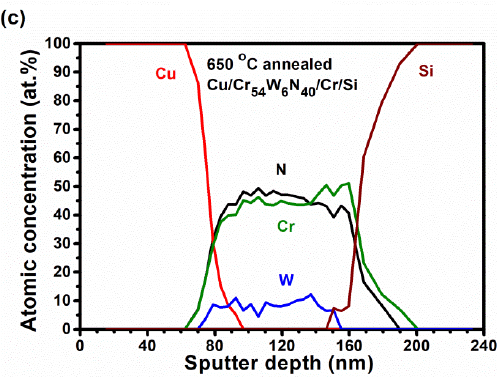
Figure 15. AES depth profiles of ( a ) as-deposited, ( b ) 600 °C, and ( c ) 650 °C annealed Cu/Cr 54 W 6 N 40 /Cr/Si samples. (Annealed in vacuum for 1 h)